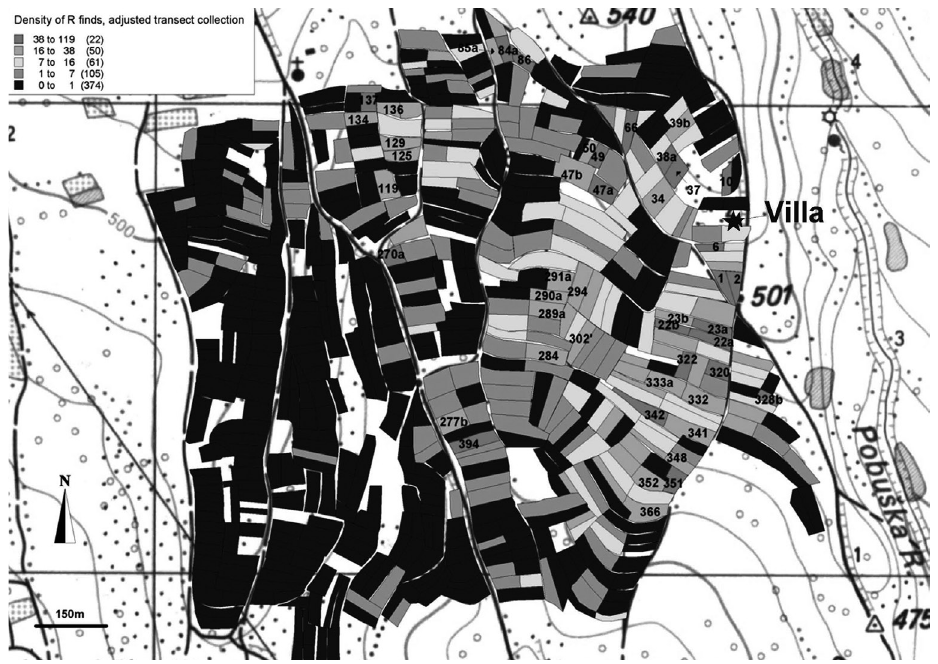
Figure 4: The distribution of surface finds by field